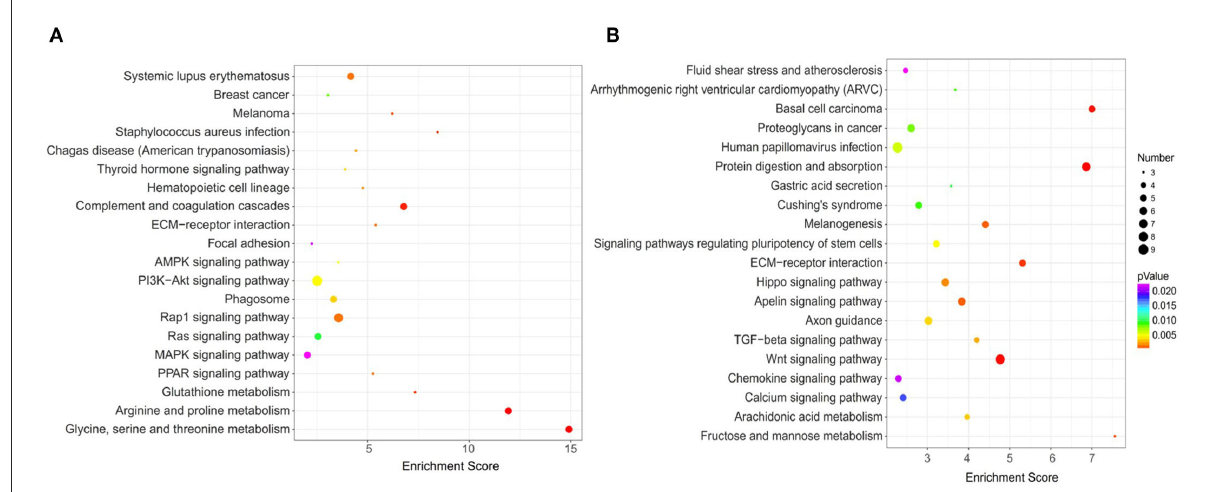
FIGURE9 KEGG pathway enrichment analysis of DEGs. (A) Top 20 of enriched pathways for 121 upregulated DEGs; (B) Top 20 of enriched pathways for 200 downregulated DEGs.